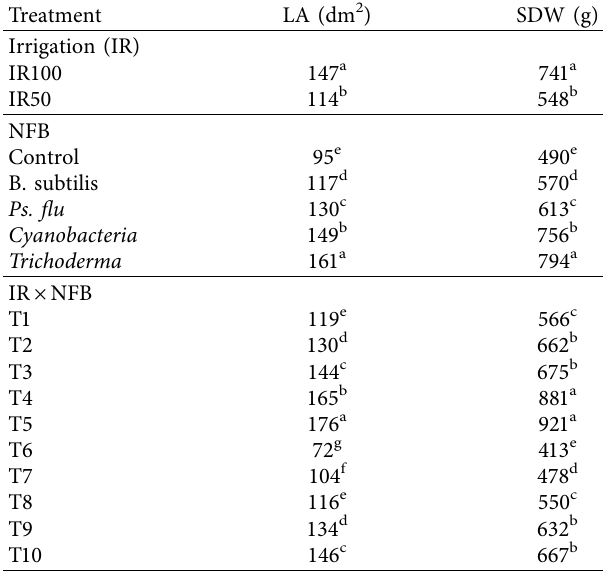
Table 5: Effects of nitrogen-fixing bacteria (NFB) on leaf area per plant (LA) in dm 2 and shoot dry weight per plant (g) of clary ( Salvia sclarea ) plants grown under two irrigation (IR)